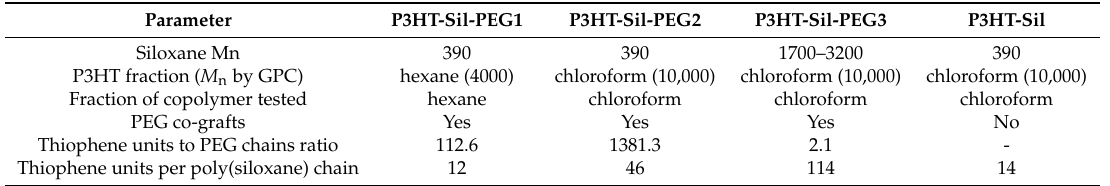
Table 1. Details of the copolymers’ composition. Thiophene units to PEG chains ratio and thiophene units per poly(siloxane) chain were estimated based on 1 H-NMR